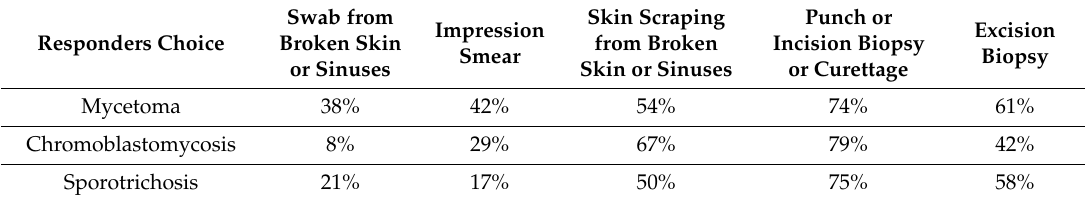
Table 3. Method of collecting material for laboratory investigation (positive